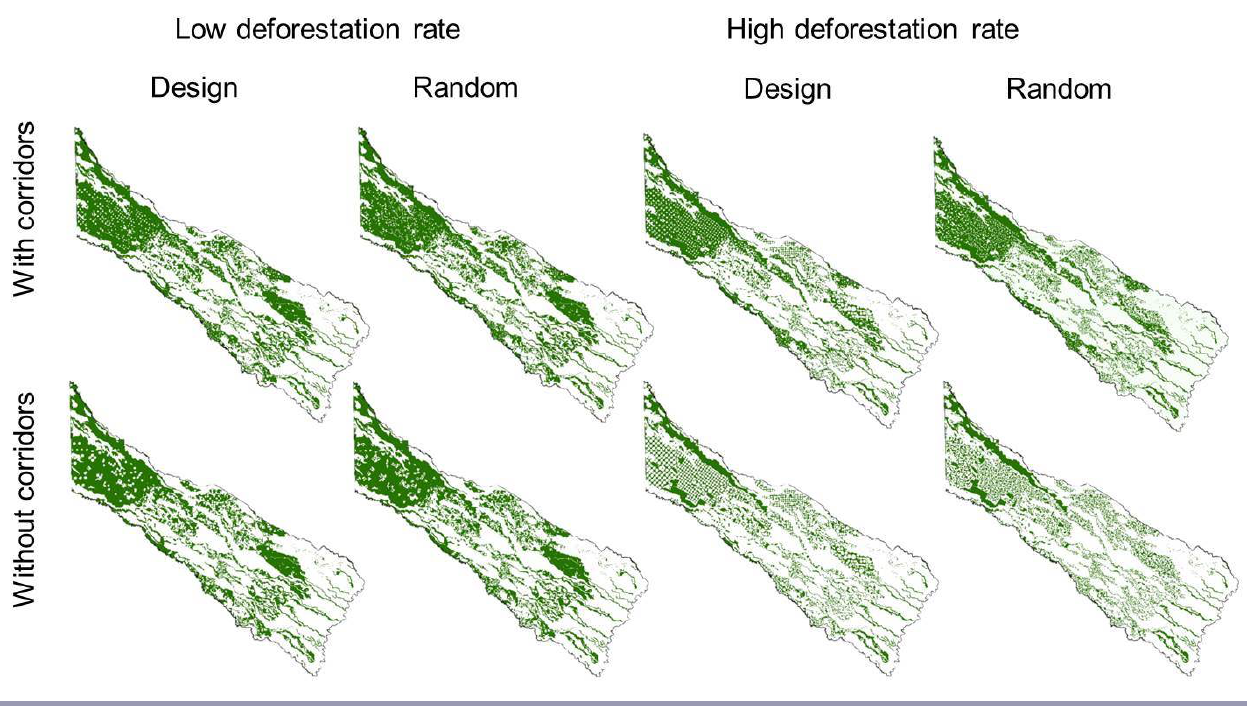
forests would be cleared in Formosa (26% of all forest in 2015), which would leave a forest cover of 31% at the province level (Table 2). Without the stricter regulations inside corridor zones, an additional 650,000 ha of forest would be lost (Table